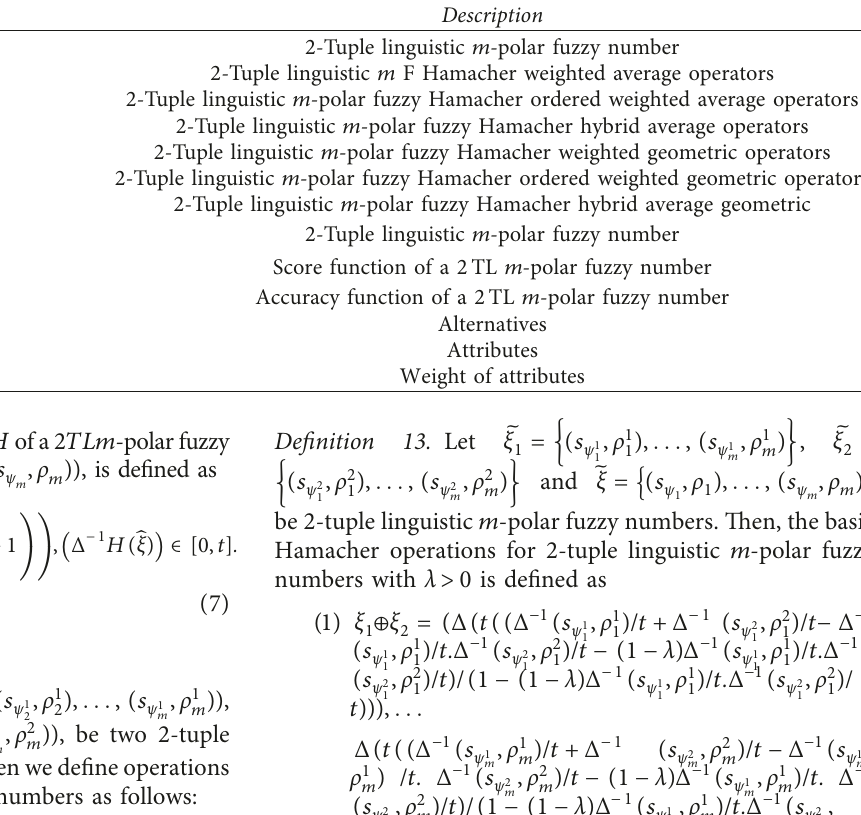
Table 1: Nomenclature of proposed